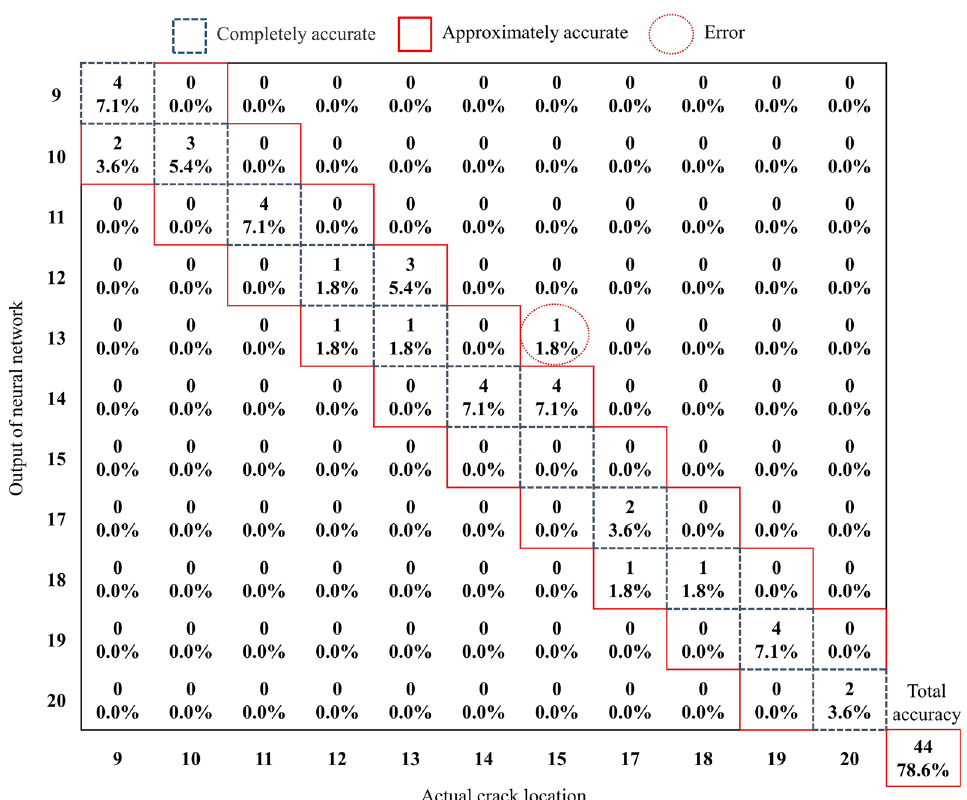
Figure 17 The confusion matrix between the PRNN’s output results and the actual crack